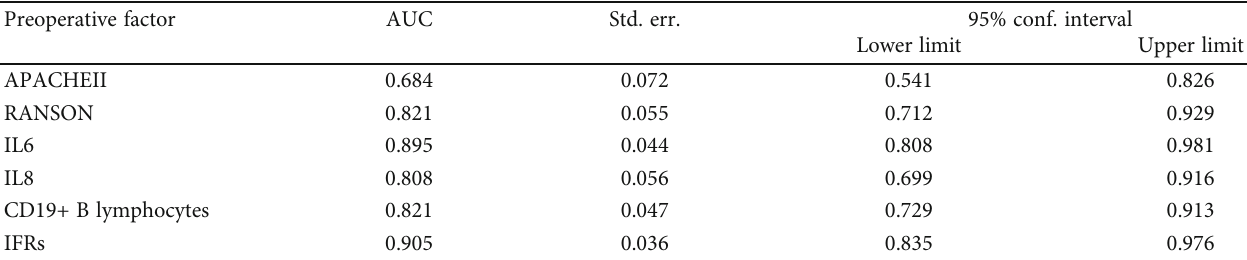
Table 5: predictive value of IRFs model and other clinical factors for